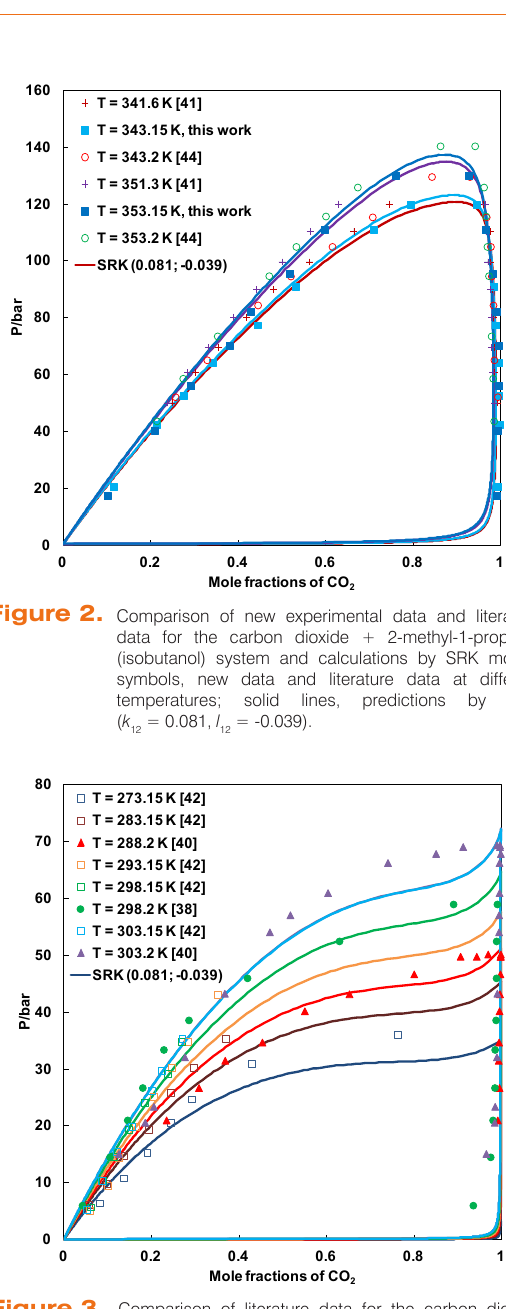
Figure 5. Comparison of literature data for the carbon dioxide + 2-methyl-1-propanol (isobutanol) system and calculations by SRK model: symbols, literature data at different temperatures; solid lines, predictions by SRK ( k = 0.081, l = 12 12